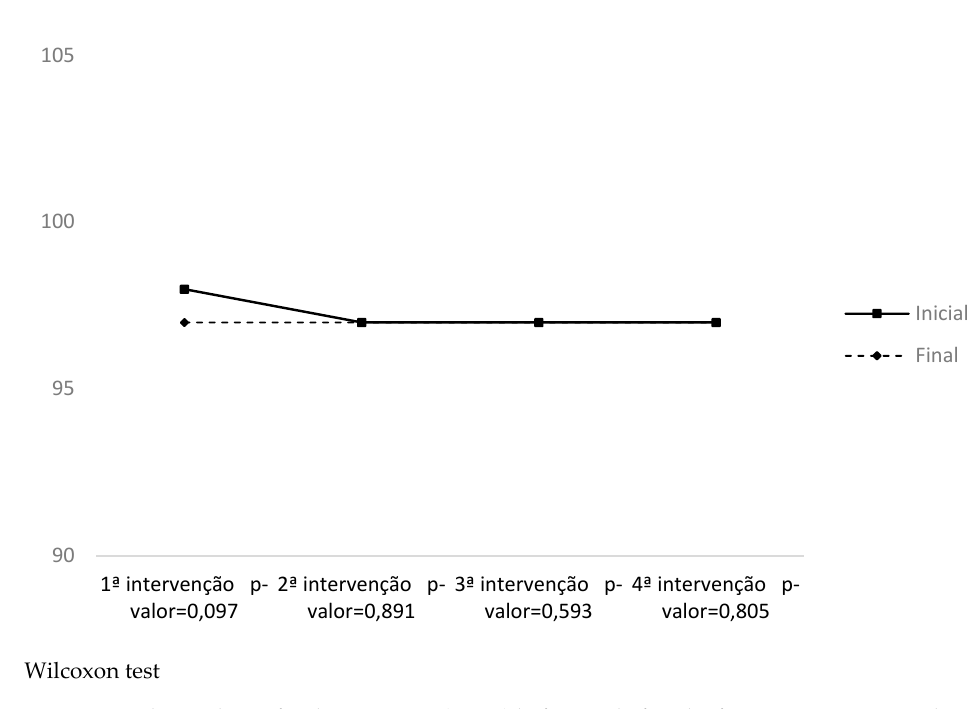
Figure 9. Median values of pulse oximetry (SPO2) before and after the four interventions in the CG (educational activity).